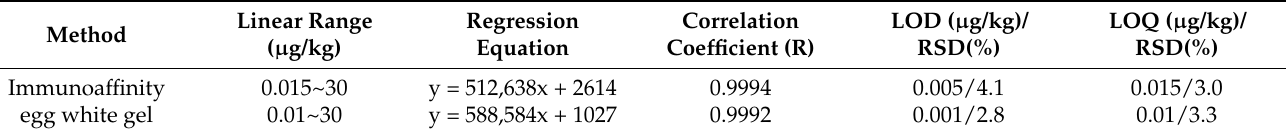
Table 2. Regression equation, R, linear range, LOD, and LOQ for LC-MS/MS analysis of AFM1 ( n = 5).